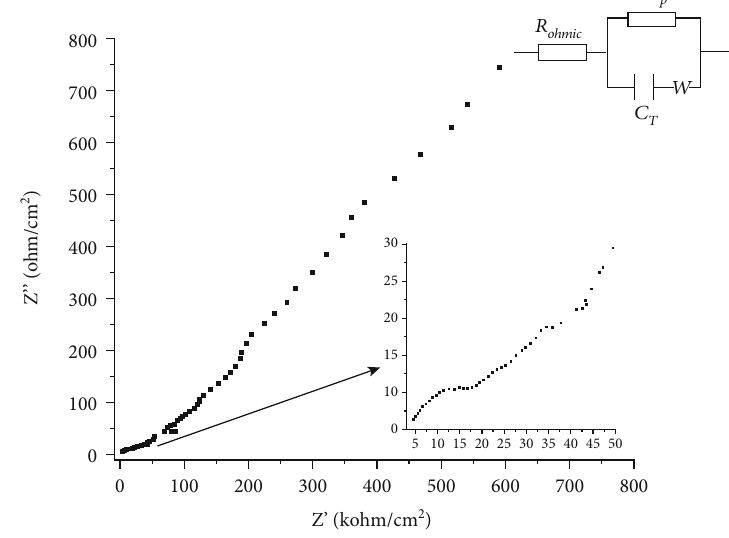
Figure 10: Nyquist diagrams for the device with CNC.